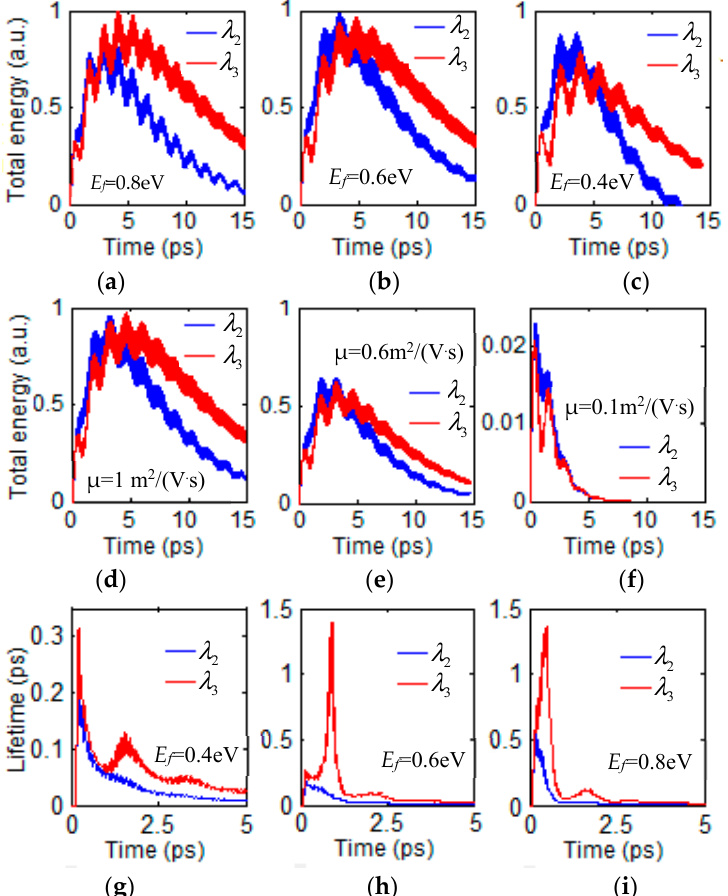
Figure 6. ( a – c ) The time evolution of total energy with time at λ 2 and λ 3 with E f = 0.8 eV, 0.6 eV and 0.4 eV. ( d – f ) Evolution of total energy with time at λ 2 and λ 3 with μ = 1, 0.6 and 0.1 m 2 /(V·s). ( g – i ) The time evolution of lifetime at wavelengths λ 2 and λ 3 with various E f = 0.4 eV, 0.6 eV and 0.8 eV. For the case μ = 1 m 2 /(V·s) and n 1 = 1, the dynamics evolution of lifetimes at wave- lengths λ 2 and λ 3 various with three different values of E f = 0.4 eV, 0.6 eV and 0.8 eV are represented with FDTD simulation in Figure 6g–i, respectively. The lifetimes can almost reach 1.4 ps for the cases E f = 0.6 eV and 0.80 eV. The lifetime of the mode λ 2 has a more